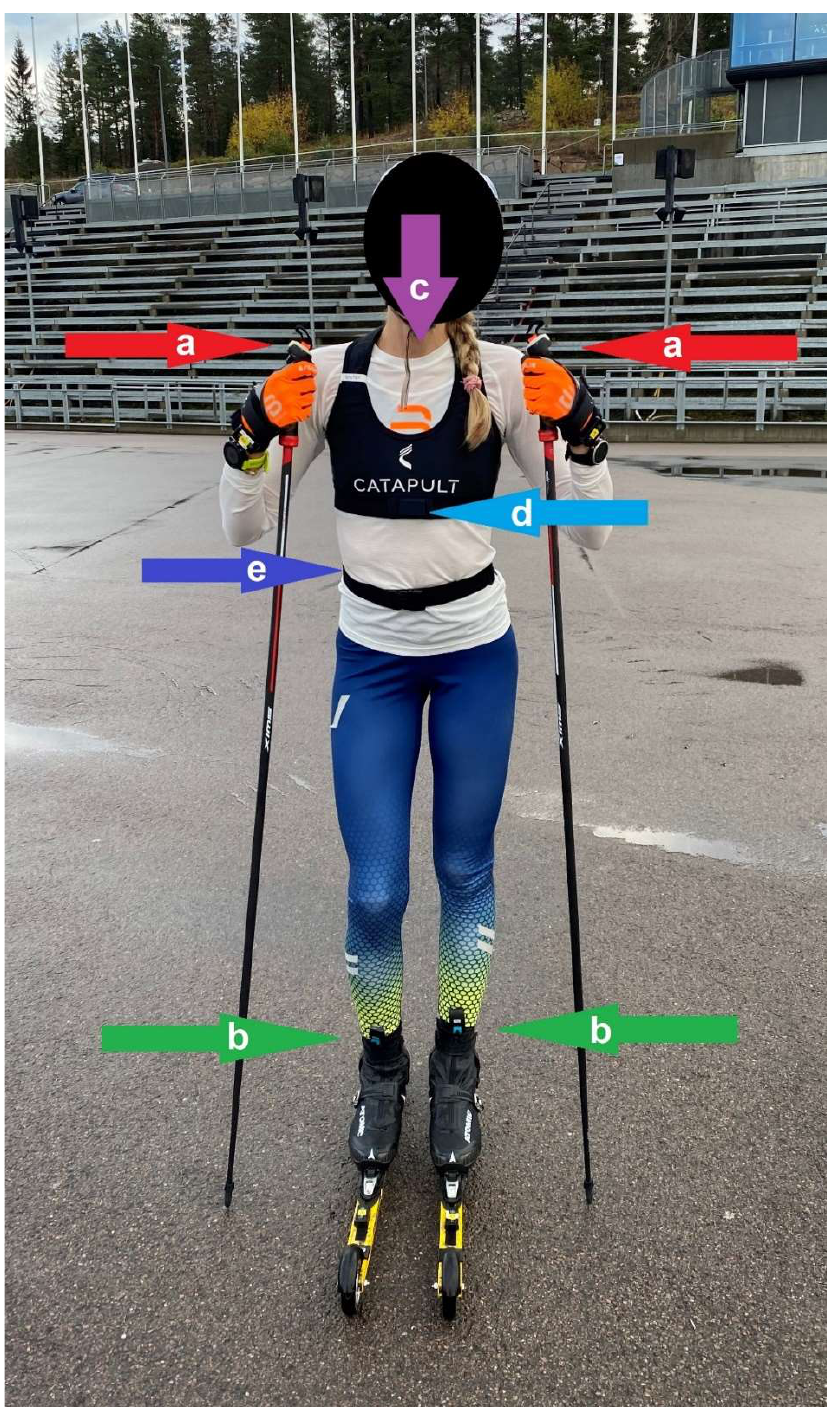
Figure 2. Experimental setup showing the equipment, with the force poles indicated with red arrows ( a ), force insoles with green arrows ( b ), catapult sensor on the upper back (hidden) with a purple arrow ( c ), IMU on the sternum with a light-blue arrow ( d ) and IMU on the sacrum (hidden) with a dark-blue arrow ( e ).